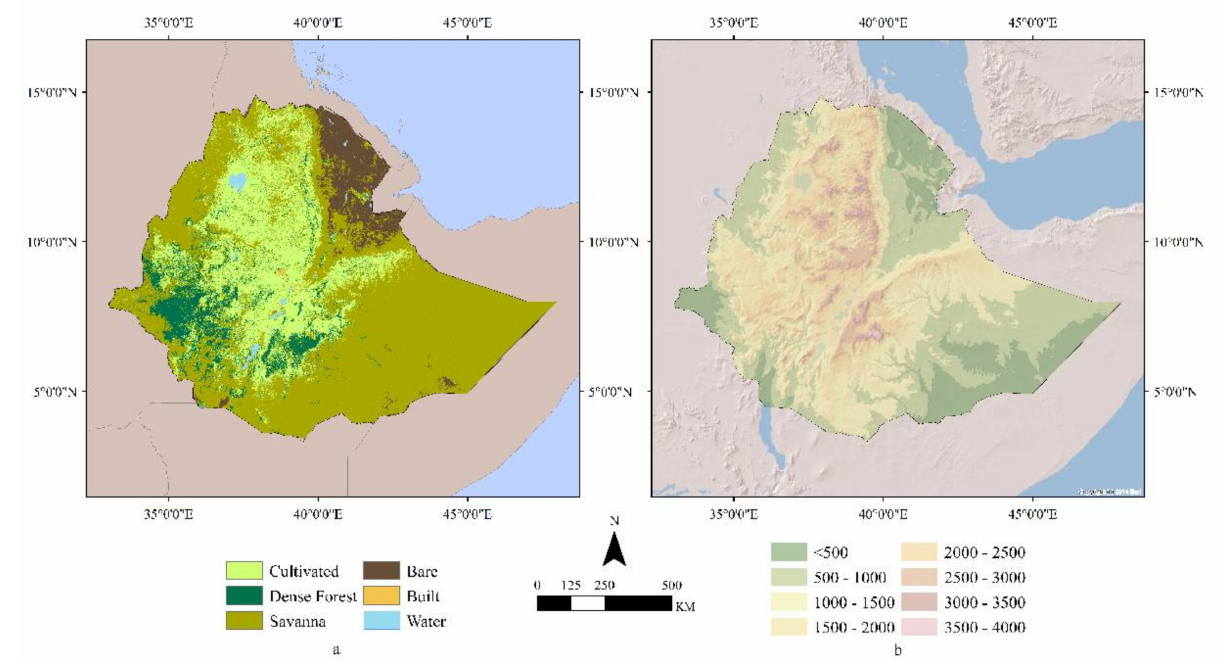
Figure 1. ( a ) Land cover of Ethiopia for 2017 based on Landsat 30 m resolution imagery from Khatami et al. [47] and ( b ) shaded relief and elevation in meters above sea level measured from the Shuttle Radar Topography Mission